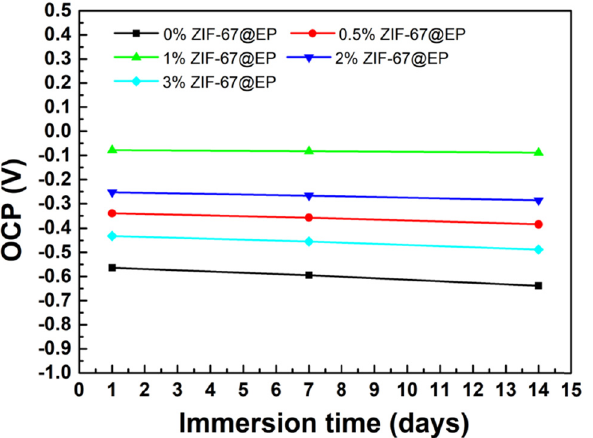
Figure 6: Potentiodynamic polarization plots of the substrates protected by di ff erent coatings.